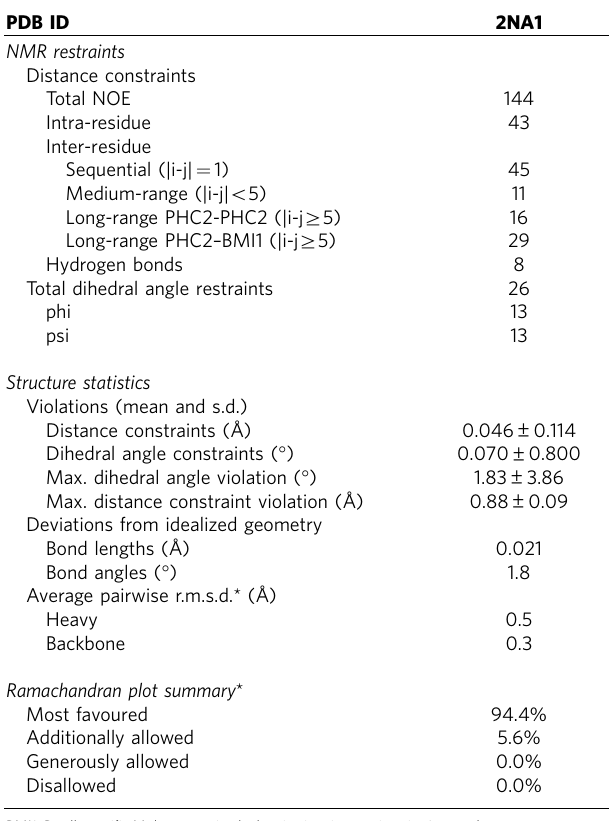
Table 2 | NMR restraints and refinement statistics for the PHC2–BMI1